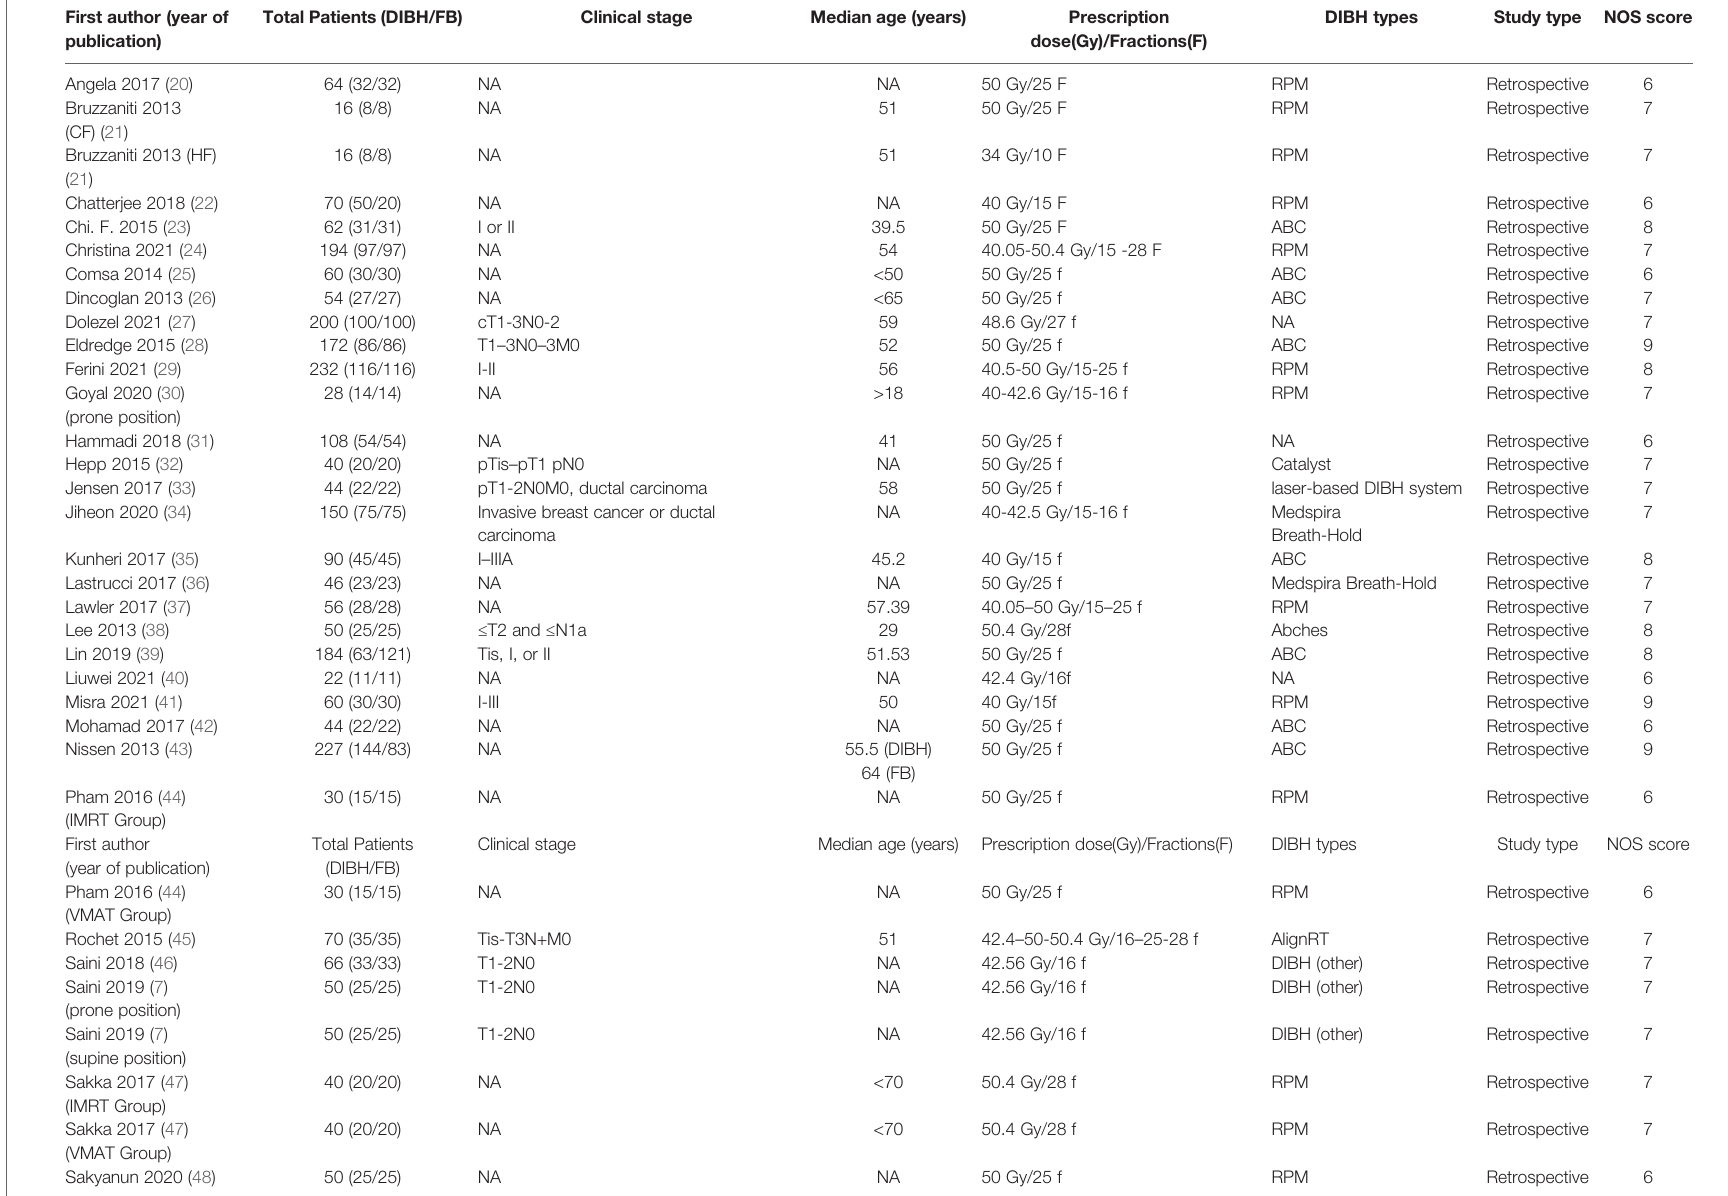
TABLE 1 | Characteristics of the studies included in the